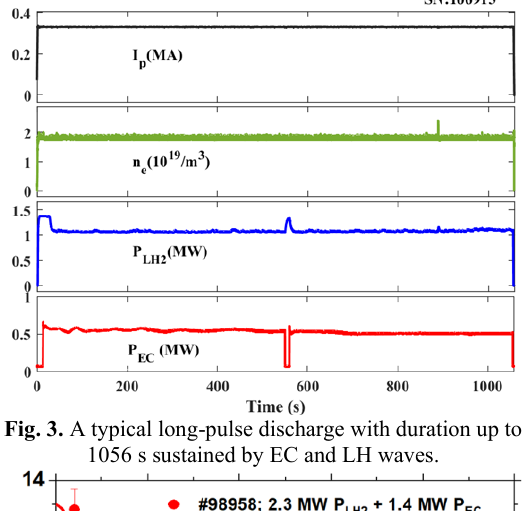
Fig. 3. A typical long-pulse discharge with duration up to 1056 s sustained by EC and LH waves.